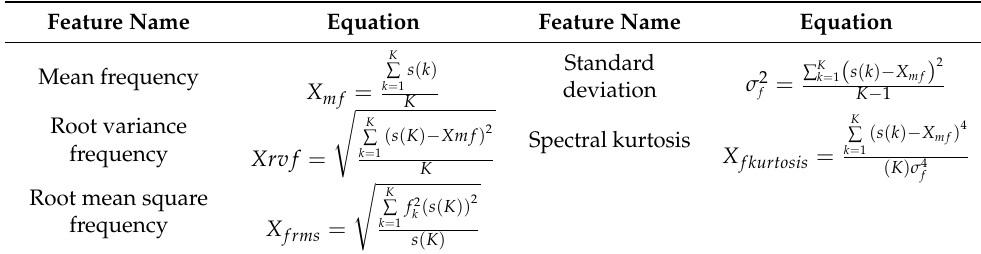
Table 2. Frequency domain SF’s extracted from the FSFB. The s ( k ) is the FSFB spectrum, k is the sample of spectrum, and f k is the value of frequency at spectrum sample k